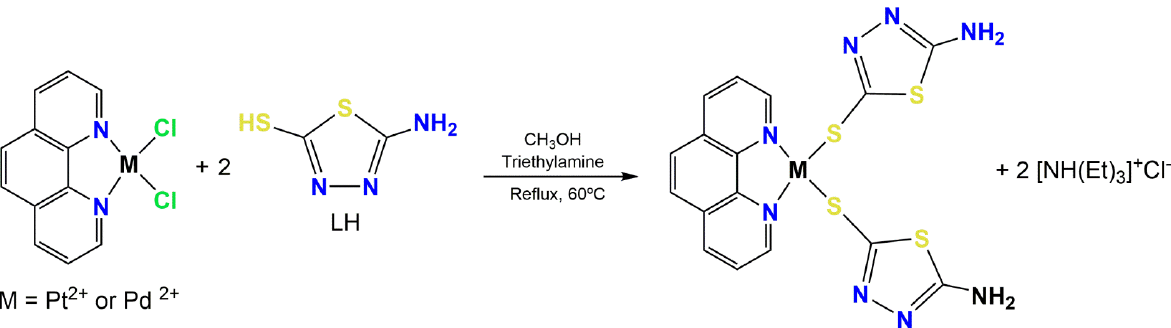
Figure 1. Synthetic route and structure proposed for complex I and II .